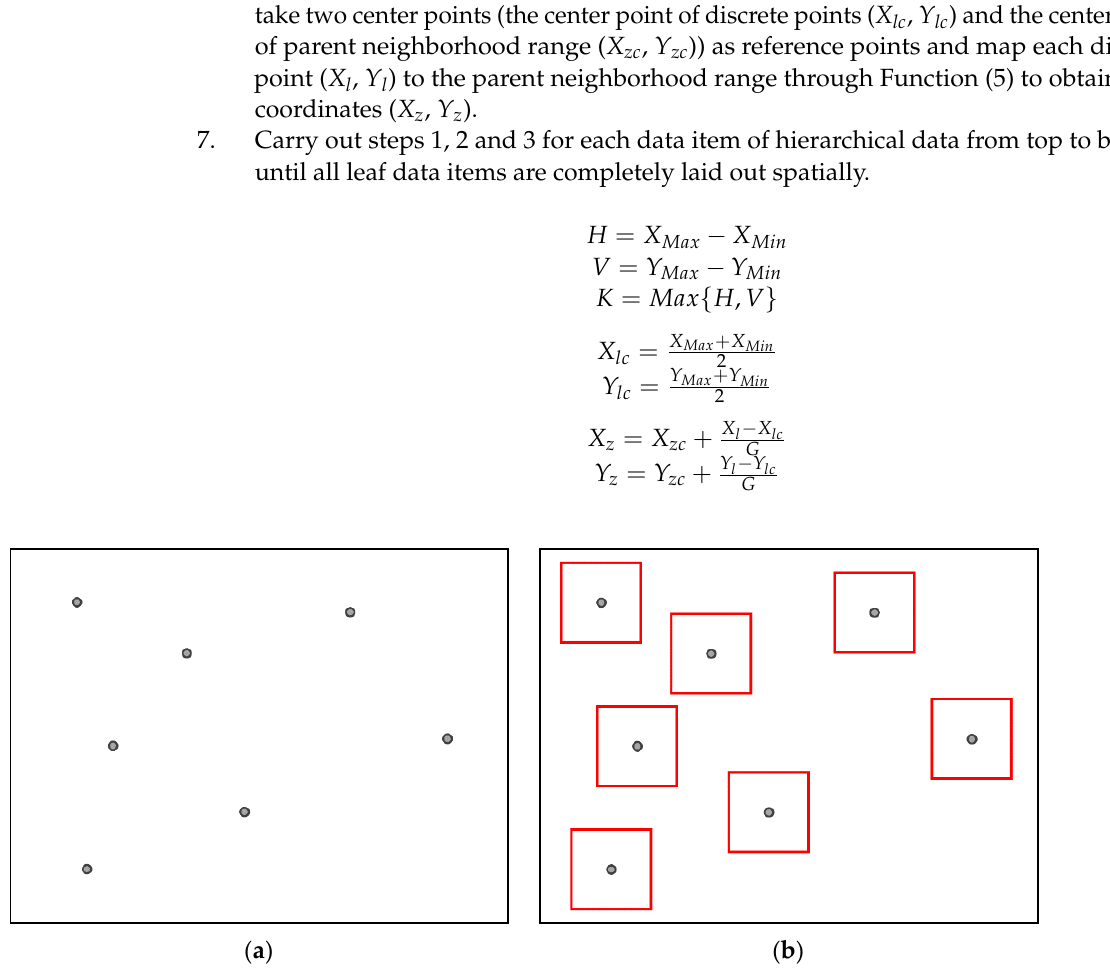
( b ) Figure 4. Interpolation results of kernel density estimation interpolation: ( a ) two-dimensional result; ( b ) three-dimensional result.